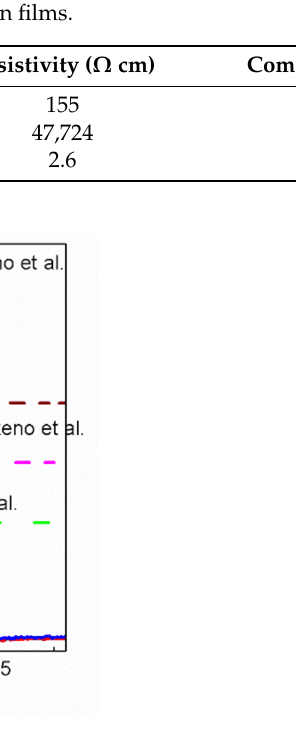
Figure 4. Ni L 3 edge ELNES spectra of NiO thin films with different oxygen flow rates. The theoretical spectra of NiO and LiNiO 2 calculated by Ikeno et al. [32] are presented for comparison. The intensity has been normalized by the